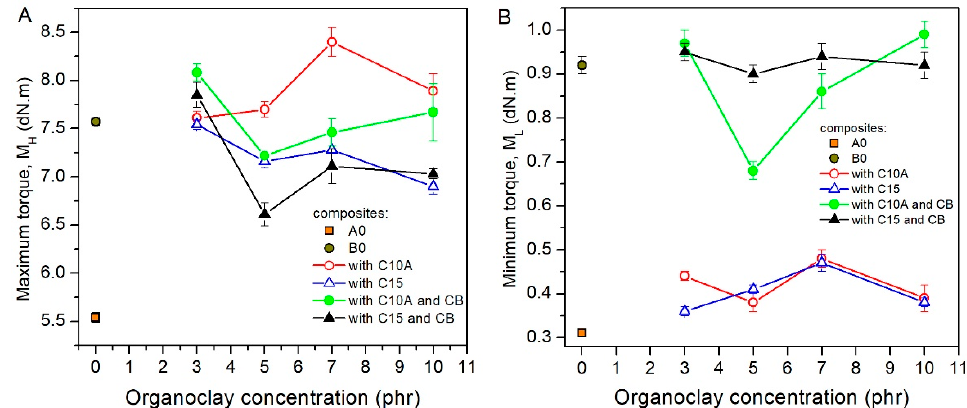
Figure 4. Curing torques of rubber nanocomposites. ( A ) Maximum torques of cured nanocomposites (M H ). ( B ) Minimum torques of nanocomposites before the curing start (M L ).